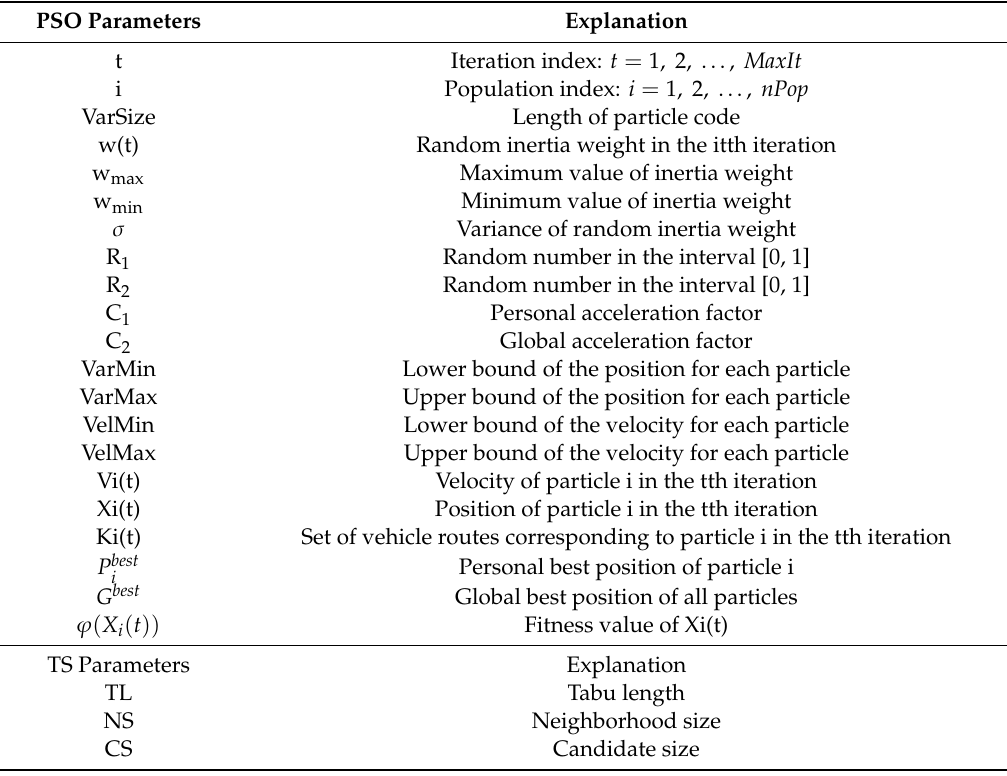
Table A1. Notations and parameters of the PSO-TS